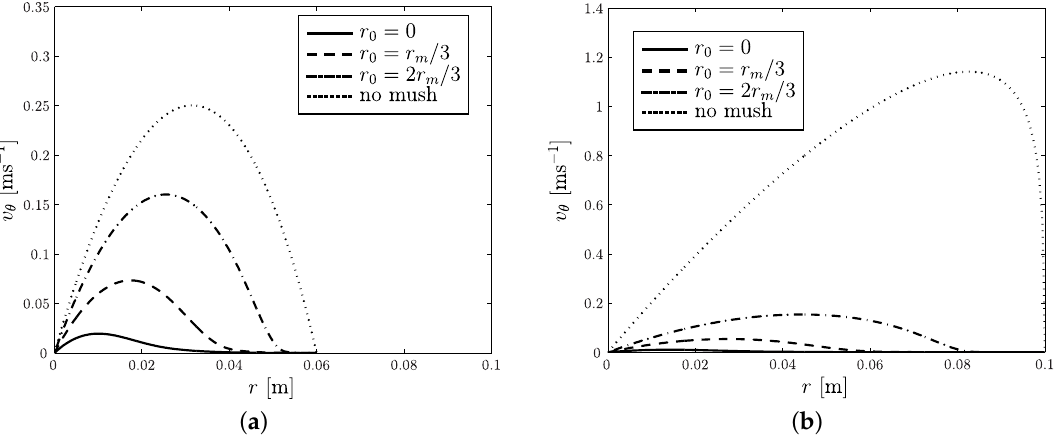
Figure 16. Azimuthal velocity, v θ , vs. radial distance, r , for r 0 = 0, r m /3, 2 r m /3 and no mush, with: ( a ) r m = 0.06 m; and ( b ) r m = 0.1